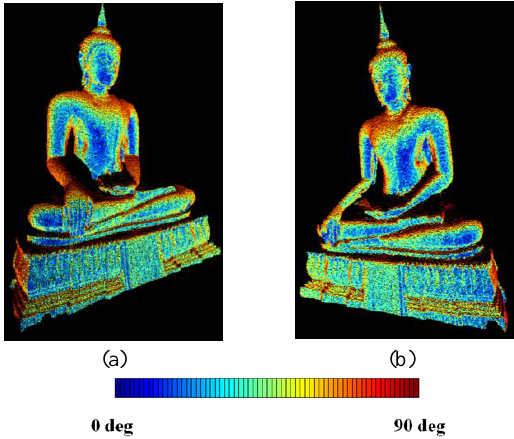
variances for the 3 variants were statistically different to P2P.